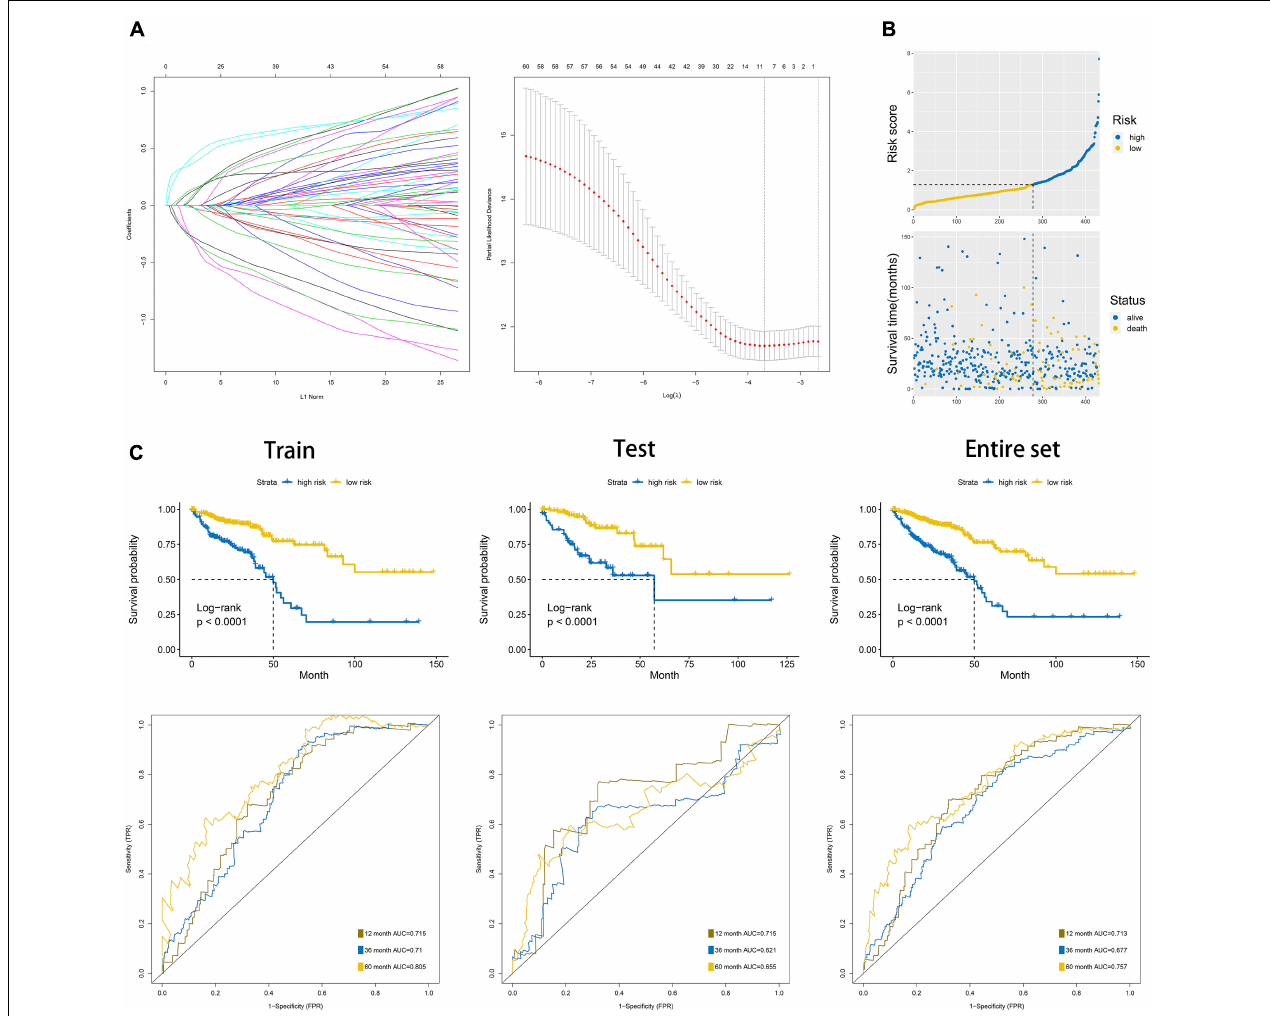
FIGURE 7 | Construction of the overall survival prognostic signature based on 60 differentially expressed UPS-associated genes in CRC. (A) Results of the least absolute shrinkage and selection operator (LASSO) analysis. (B) Risk score analysis of the signature in the internal training dataset. (C) Kaplan–Meier plots and area under the curve (AUC) of receiver operating characteristic (ROC) curve in the internal training, internal test, and entire